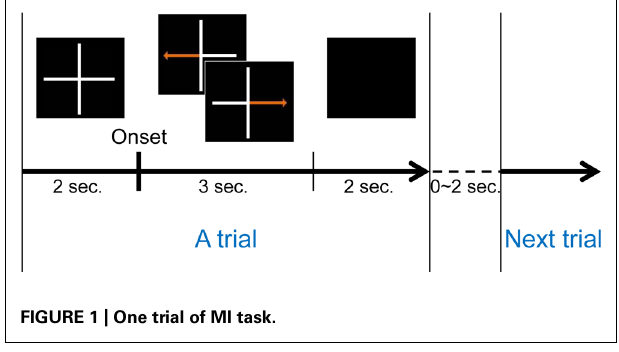
FIGURE 1 | One trial of MI